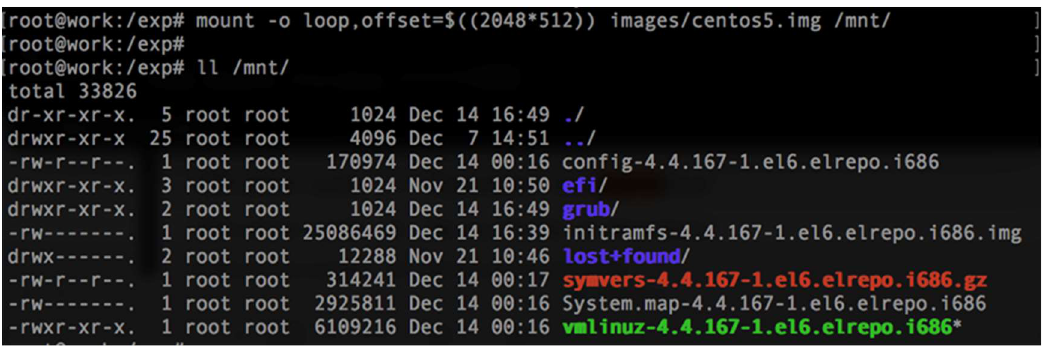
Figure 10. Mount and view the/boot partition of VM5, without PVMH.